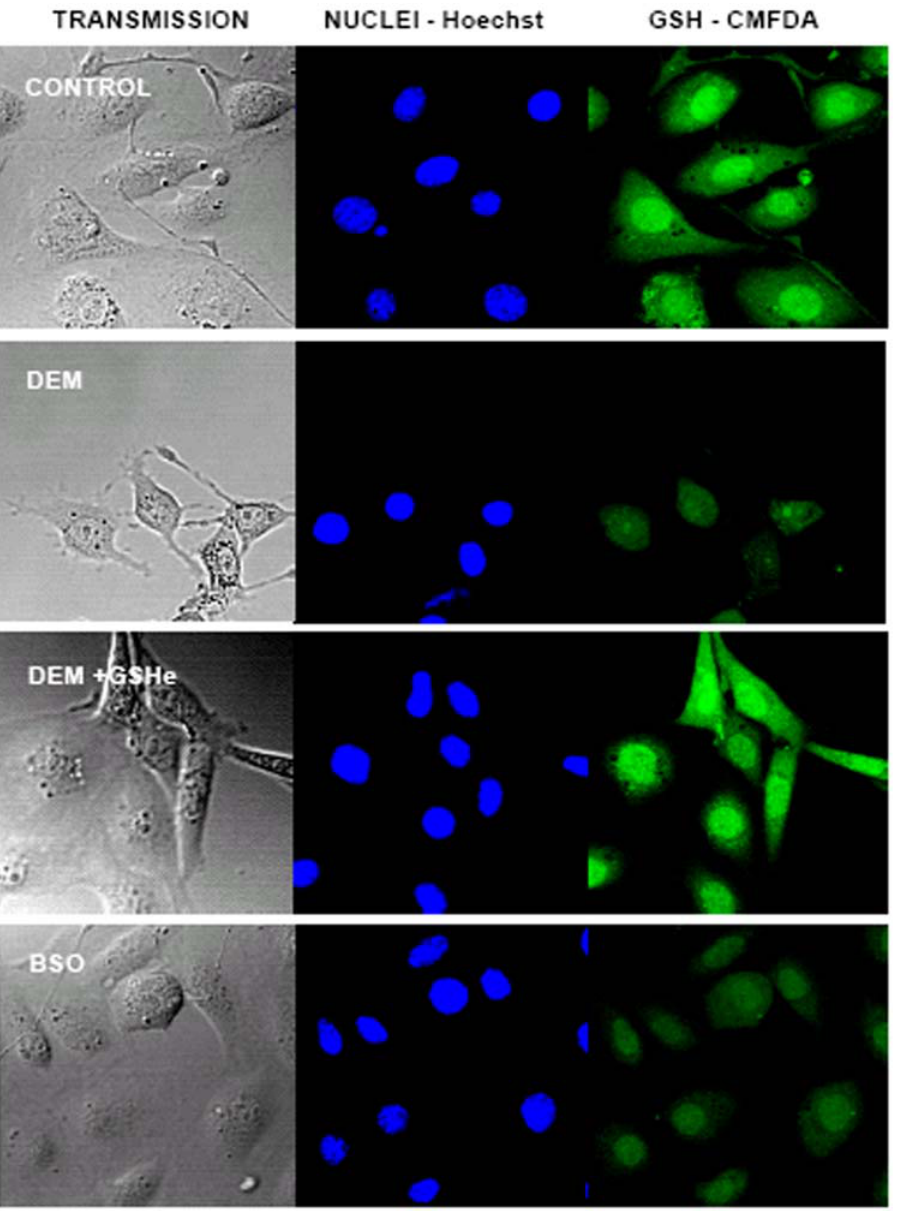
Figure 3. The GSH distribution after its depletion with DEM and BSO. The cells were plated as usual and after attaching, 100 m M DEM, or 10 mM BSO, or 100 m M DEM + 1 mM GSHe were added. At 24 h after plating the cells were stained as described in Materials and Methods and observed by confocal microscopy in the chamber provided with 5% CO 2 and at 37 u C. Images were taken by light microscopy (transmission) and by confocal microscopy, as described in Materials and Methods, to capture blue fluorescence of nuclei (Hoechst-nuclei), green fluorescence that marks GSH (CMFDA-GSH) and red fluorescence of dead cells (PI-dead cells) (results not shown). Z series of at least 8 planes were obtained and maximum projection images were created and analysed. The representative experiment (of five) is